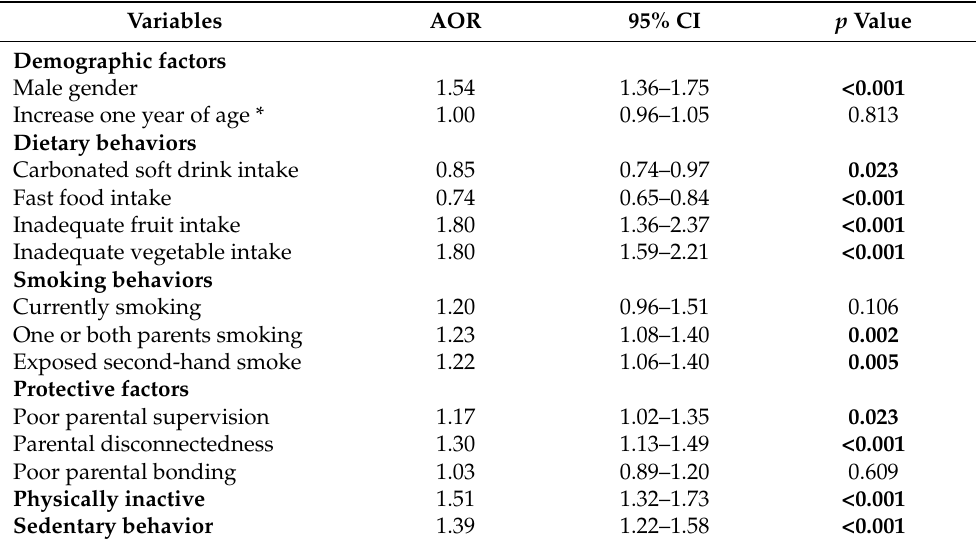
Table 2. Sample characteristics associated with poor oral hygiene among school-going students in Mongolia (multivariable logistic